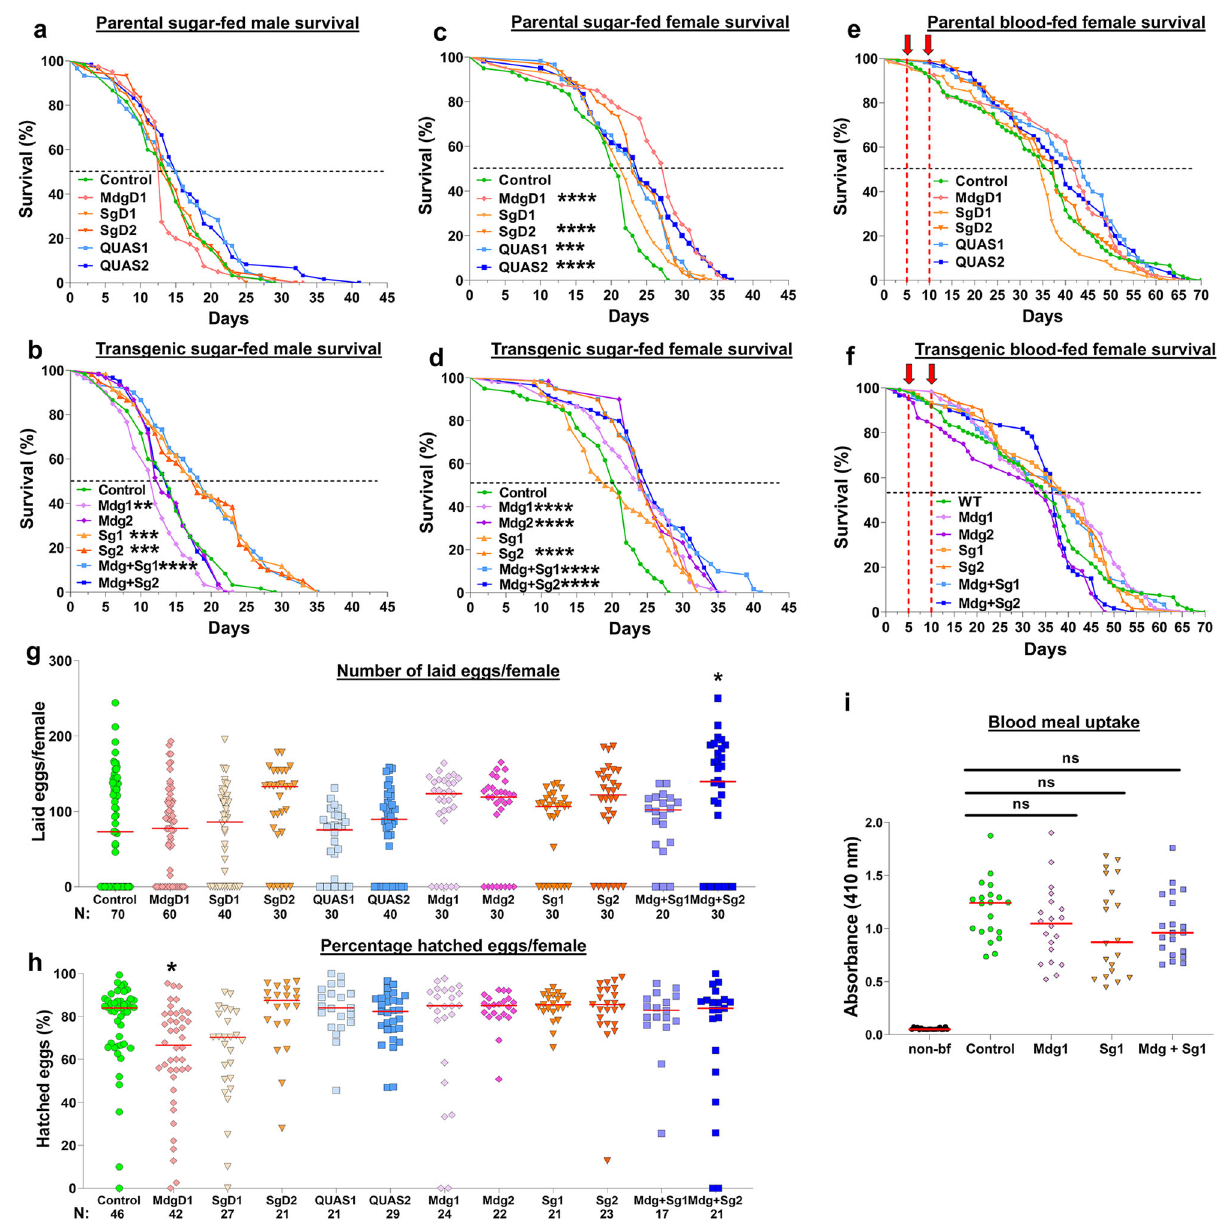
Fig. 3 Fitness analysis of An. stephensi transgenic lines. a – d The survival rates for WT, parental and transgenic lines maintained on a sugar meal were evaluated for males ( a , b ) and females ( c , d ). e , f Survival was also evaluated for females that received two consecutive blood meals (red arrows). Survival rate was calculated by Kaplan – Meier survival curves, and multiple comparisons were done by two-sided Log-rank test with Bonferroni correction across all lines. b ** P = 0.0080, *** P = 0.0001, **** P < 0.0001. c *** P = 0.0001, **** P < 0.0001. d **** P < 0.0001. N = 60 mosquitoes for each of three individual biological replicates. g , h Fecundity (number of laid eggs) ( g ) and fertility (proportion of the laid eggs that hatched) ( h ) of parental and huPAI-1 transgenic lines were evaluated from the same cohort of mosquitoes. Transgenics were compared to WT by Kruskal – Wallis multiple comparisons with Dunn ’ s post- test. * P = 0.0373. Data from at least three individual biological replicates, except for line Mdg + Sg1 which was tested in duplicate experiments ( N = 10 females/replicate). i Blood uptake is not affected in transgenic mosquitoes expressing huPAI-1. Quanti fi cation of protein-bound heme at 410 nm from midguts of WT and transgenic mosquitoes before (non-bf) and after a blood meal. Horizontal red lines represent the median of data pooled from two independent experiments ( N = 10 females/replicate). Statistical analysis was determined by Kruskal – Wallis multiple comparisons with Dunn ’ s post-test. ns not signi fi cant. N = 20 females per compared to the WT mosquitoes, except for females of the offspring production for the transgenic lines when compared to Mdg + Sg2 line that laid signi fi cantly more eggs than WT the control group. (Fig. 3g). Next, we analyzed the fertility rate from the same cohort To determine if huPAI-1 expression in midgut and/or salivary of eggs analyzed in the fecundity experiment. All the transgenic glands affects blood ingestion, we quanti fi ed protein-bound heme lines, parental and huPAI-1, showed similar fertility to WT content in midguts of blood fed females immediately after the mosquitoes, except for line MdgD1 which showed a lower fertility blood meal in a subset of transgenic lines. No differences were rate (Fig. 3h). Based on our results, there is no fi tness cost in detected (Fig. 3i), suggesting that the transgenes do not affect